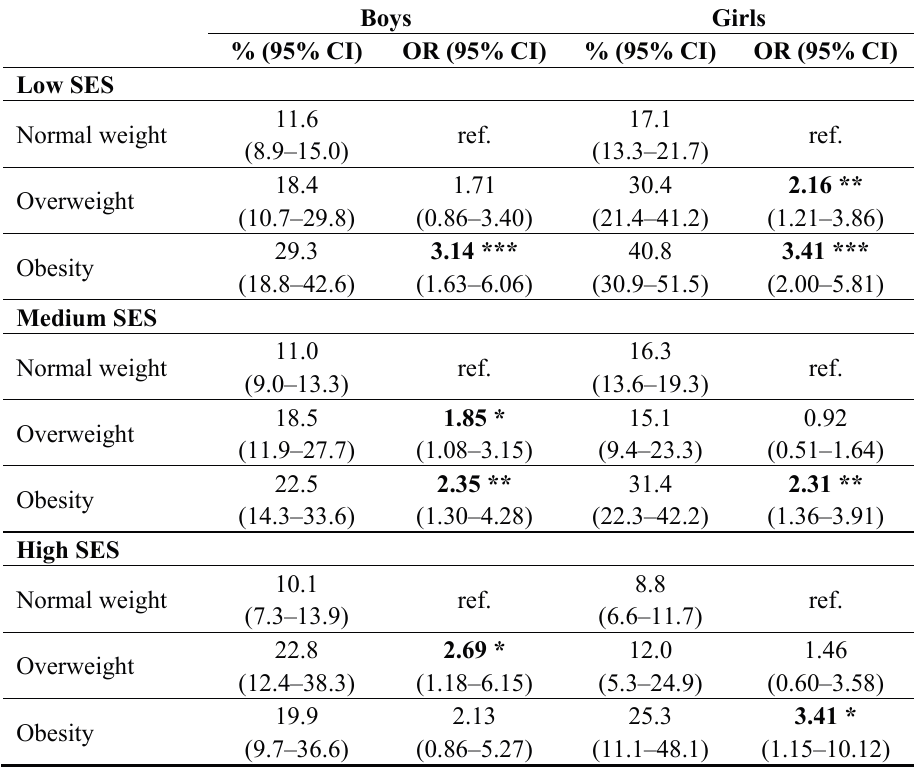
Table 3. Relation between BMI and SRH (fair to very poor) among adolescents aged 11 to 17 years stratified by SES (n = 4801). Prevalence and age-adjusted odds ratios (OR) with 95% confidence intervals (95%